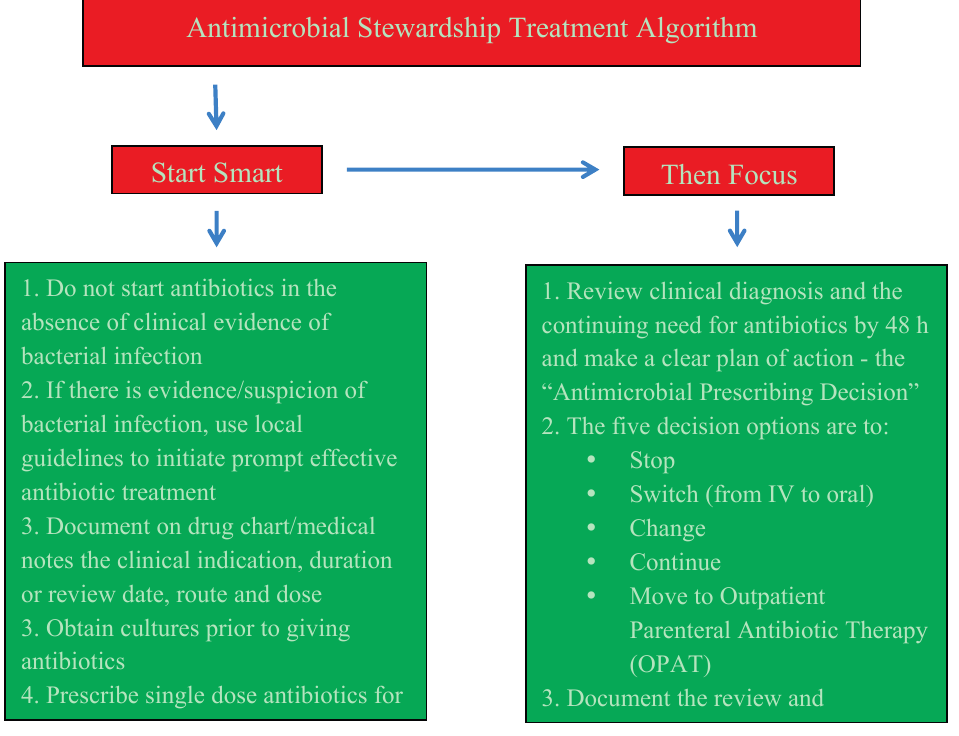
Figure 2. “Start Smart—Then Focus” antimicrobial stewardship guidance for